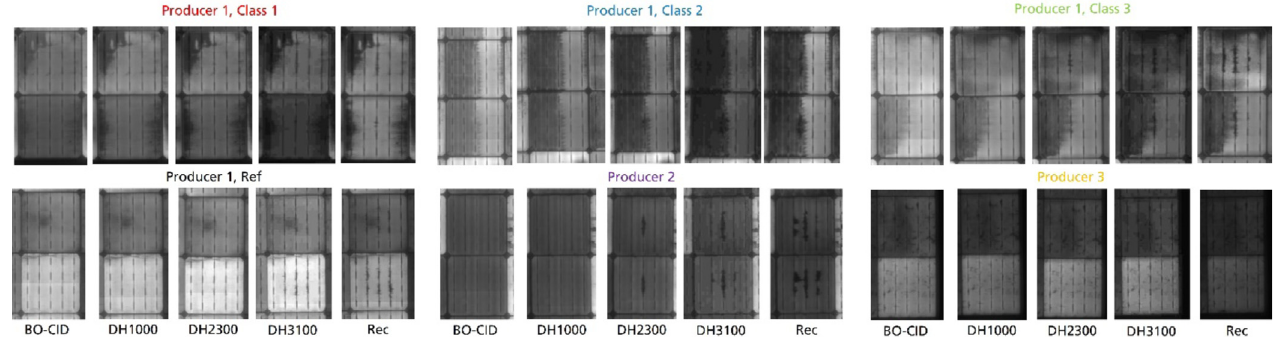
Fig. 6. Selected electroluminescence image sections from the extended damp heat test, I = 10 A, 1s.